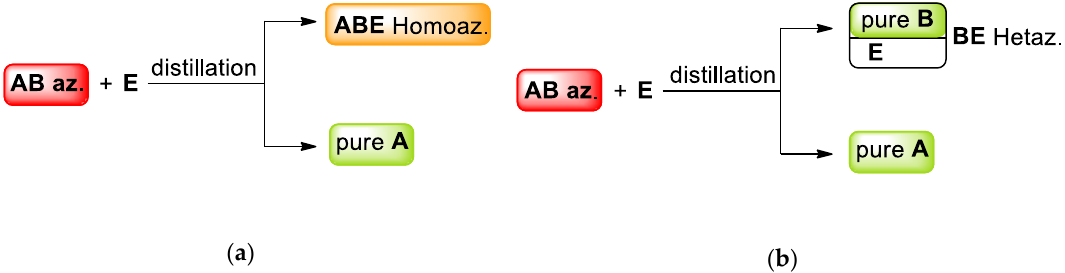
Figure 1. Schematic representation of ( a ) homogeneous azeotropic distillation; ( b ) heterogeneous azeotropic distillation.